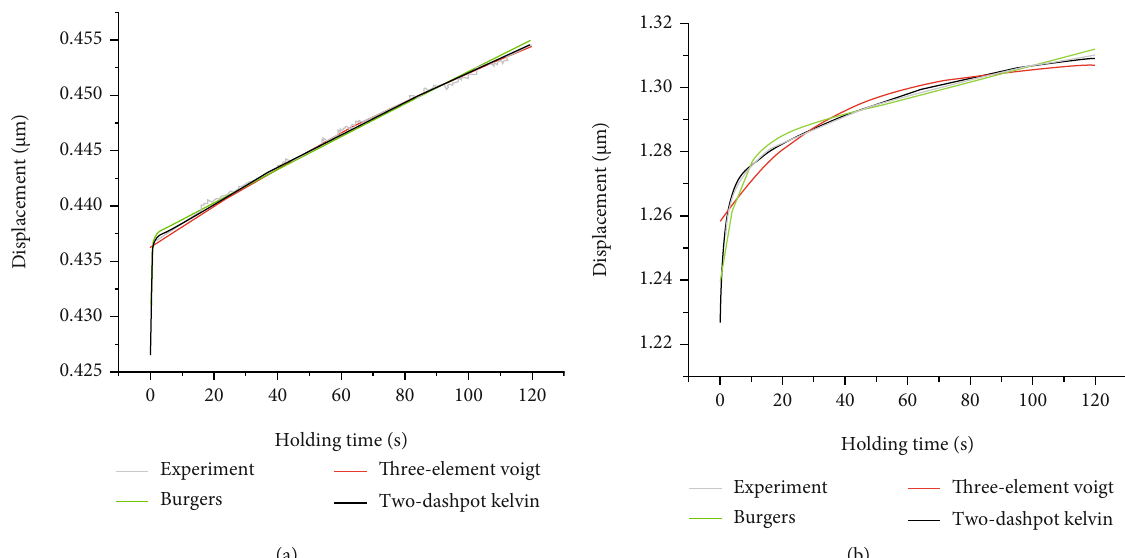
Figure 11: Regression curves obtained from di ff erent viscoelastic models at 30 mN for (a) quartz and (b) clay minerals.